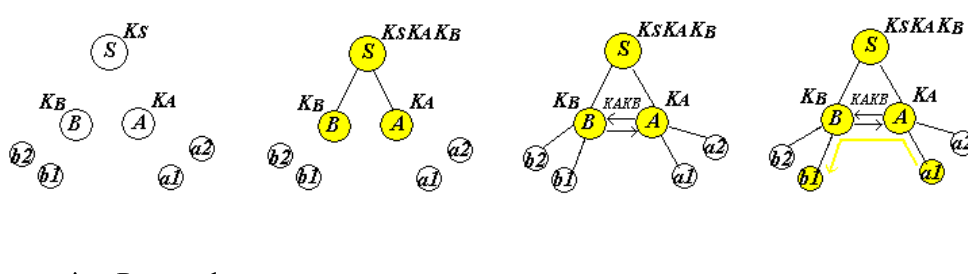
Figure 3. Direct Connection Protocol.